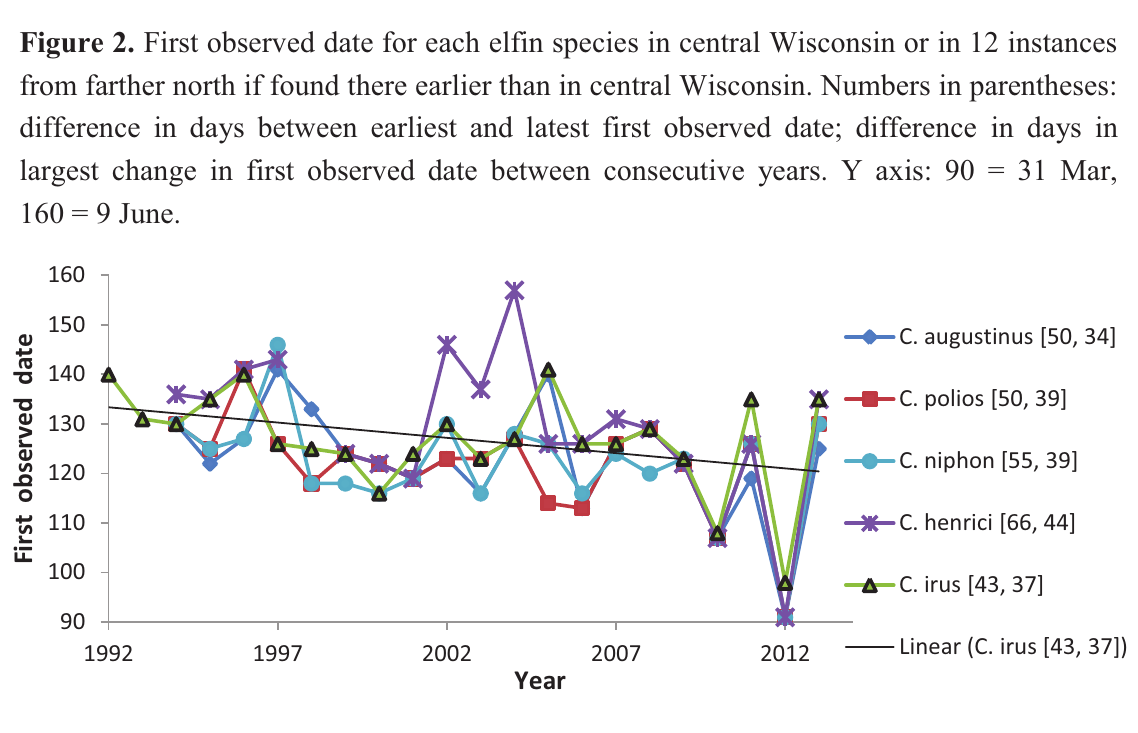
Table 3. Spearman rank correlation coefficients (r) of first observed date and year (trend over time), by species, with date calculated either using surveys only in central Wisconsin or using all survey data including from northern Wisconsin and northeastern Minnesota.